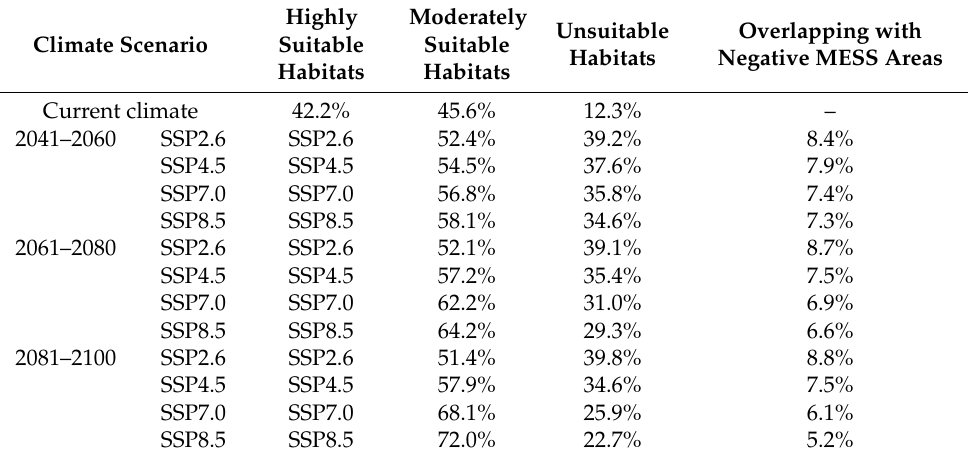
Table 2. Percent cover of highly suitable habitats (pixels with occurrence probabilities above 0.5), moderately suitable habitats (pixels with occurrence probabilities between 0.1 and 0.5), and unsuitable habitats (pixels with occurrence probabilities below 0.1) for buffelgrass estimated with the CNM under the current climate and the climate change scenarios predicted by CanESM5 on 20-year intervals considering the radiative forcing associated with the different SSPs. The last column of the table shows the percent overlapping of habitats predicted as moderately and highly suitable for buffelgrass (i.e., occurrence probabilities above 0.1) with areas containing negative MESS values at each climate change scenario.